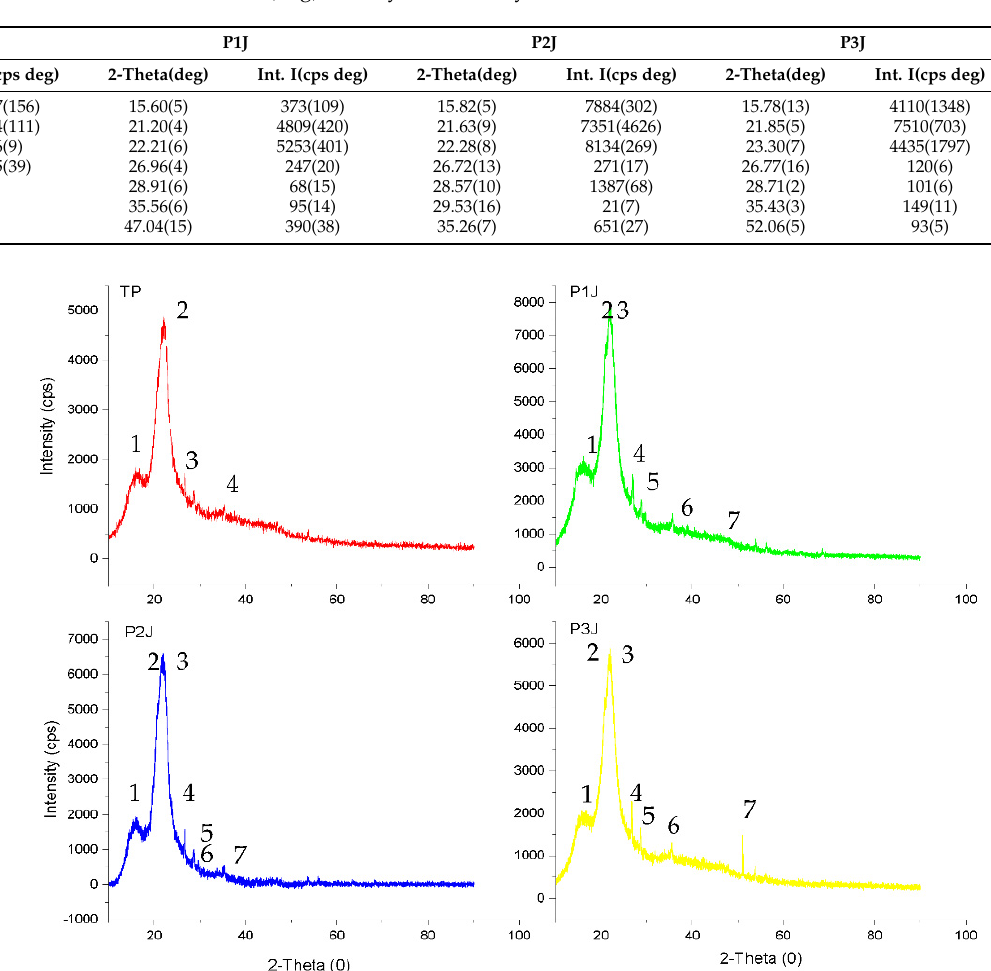
Figure 7. Intensity comparison of the XRD test of BSFs (TP, P1J, P2J, and P3J).